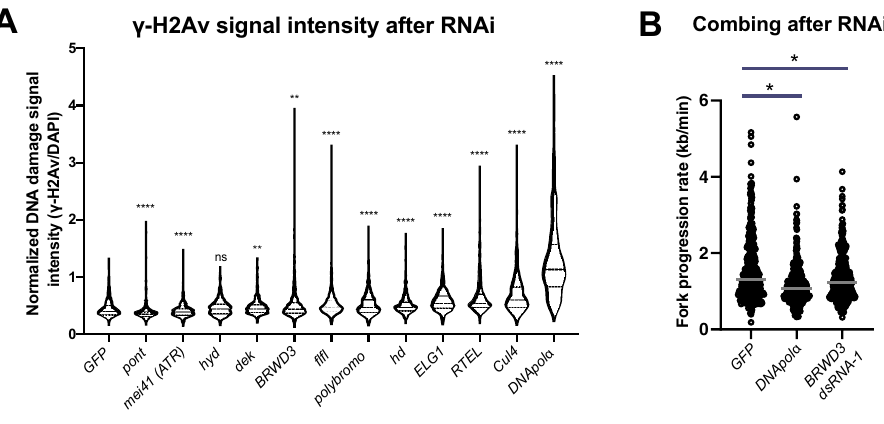
Figure 4. BRWD3 affects genome stability and replication fork progression. ( A ) RNAi-based depletion screen of candidate replication fork-associated proteins in S2 cells. Violin plots of the ɣ -H2Av intensity per nucleus normalized to total DNA content. Each distribution represents the signal intensities of 700 randomly selected cells from two biological replicates. ****p < 0.0001 and **p < 0.01 using a Kruskal–Wallis one-way analysis of variance. ( B ) Rate of fork progression in control and BRWD3 depleted S2 cells. 400 fibers from two biological replicates were pooled. BRWD3 dsRNA-1 was used for this experiment. Bars represent the median fork